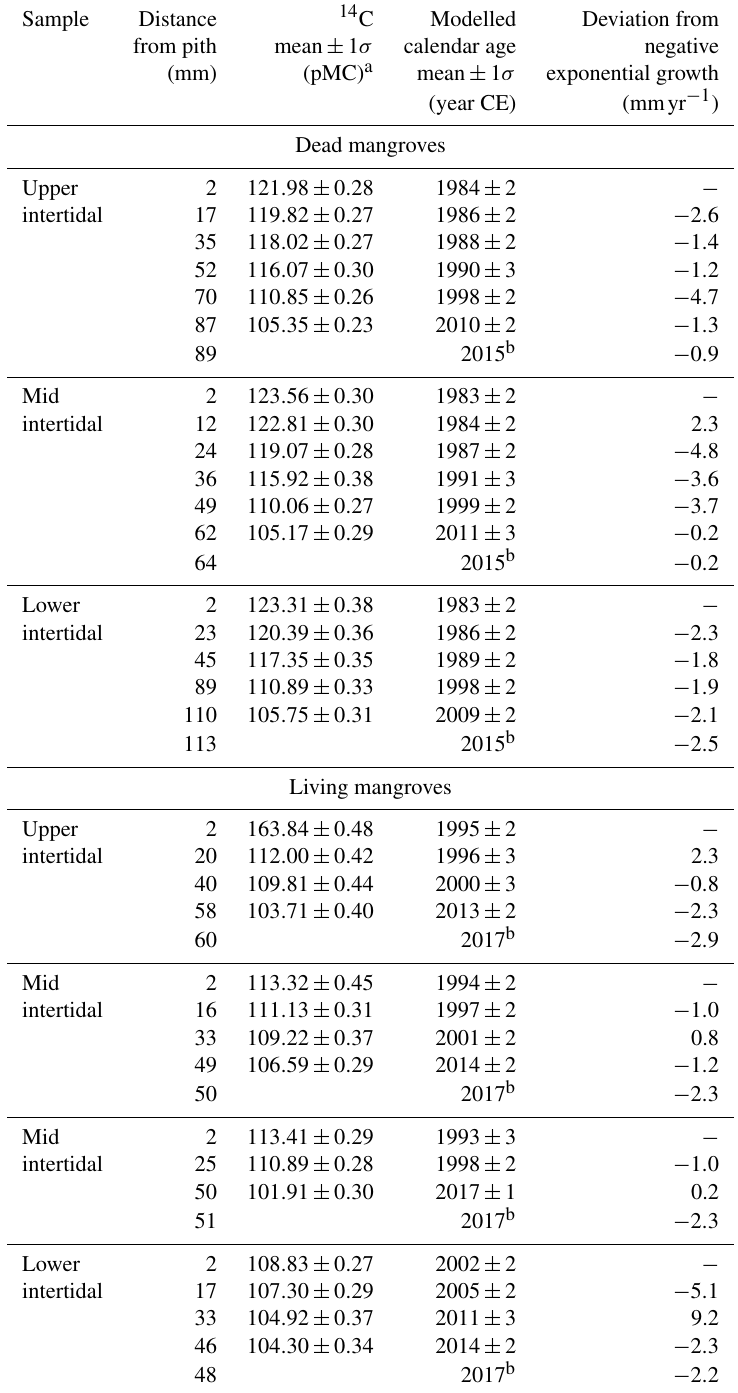
Table 1. Summary of radiocarbon ages and growth rates (deviation from negative exponential growth) for all wood samples taken from dead and living mangrove areas in the Gulf of Carpentaria,